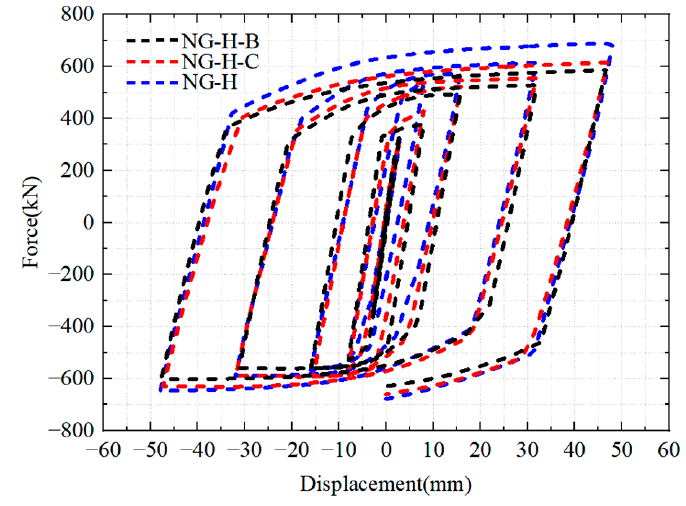
Figure 17. Comparison of hysteretic response of specimen NG-H and those with one-sided slotted gusset connection.